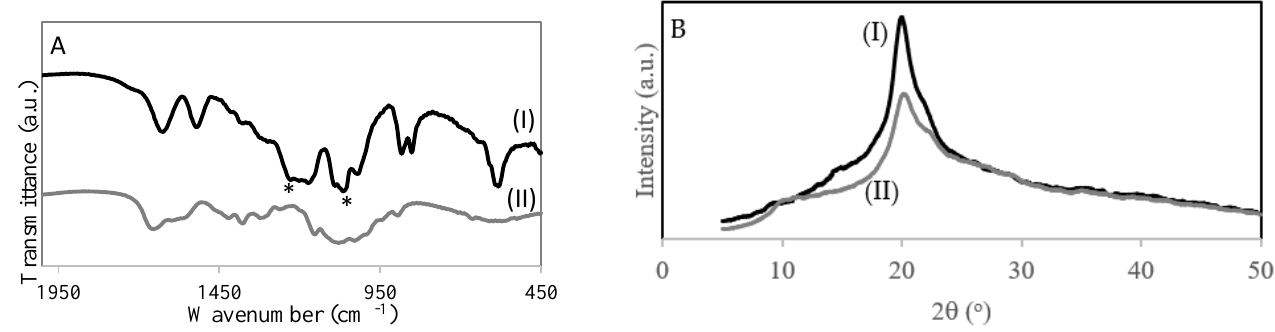
Figure 2. ( A ) FT-IR spectra of catalysts: (I) 4-CH-SO 3 H; (II) chitosan. ( B ) XRD of (I) chitosan and (II) 4–CH–SO 3 H catalyst.